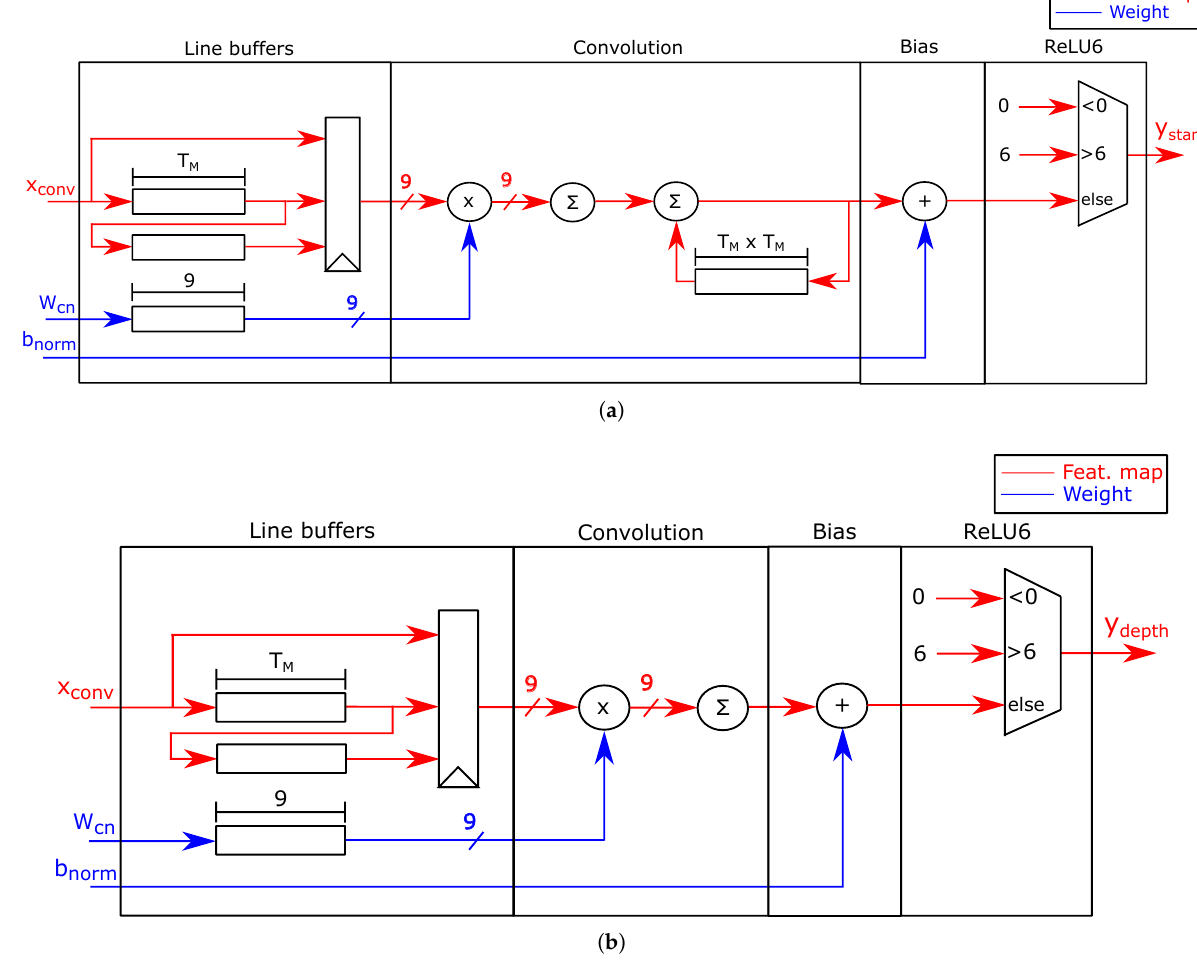
Figure 6. ( a ) Standard convolution FU; ( b ) depthwise convolution